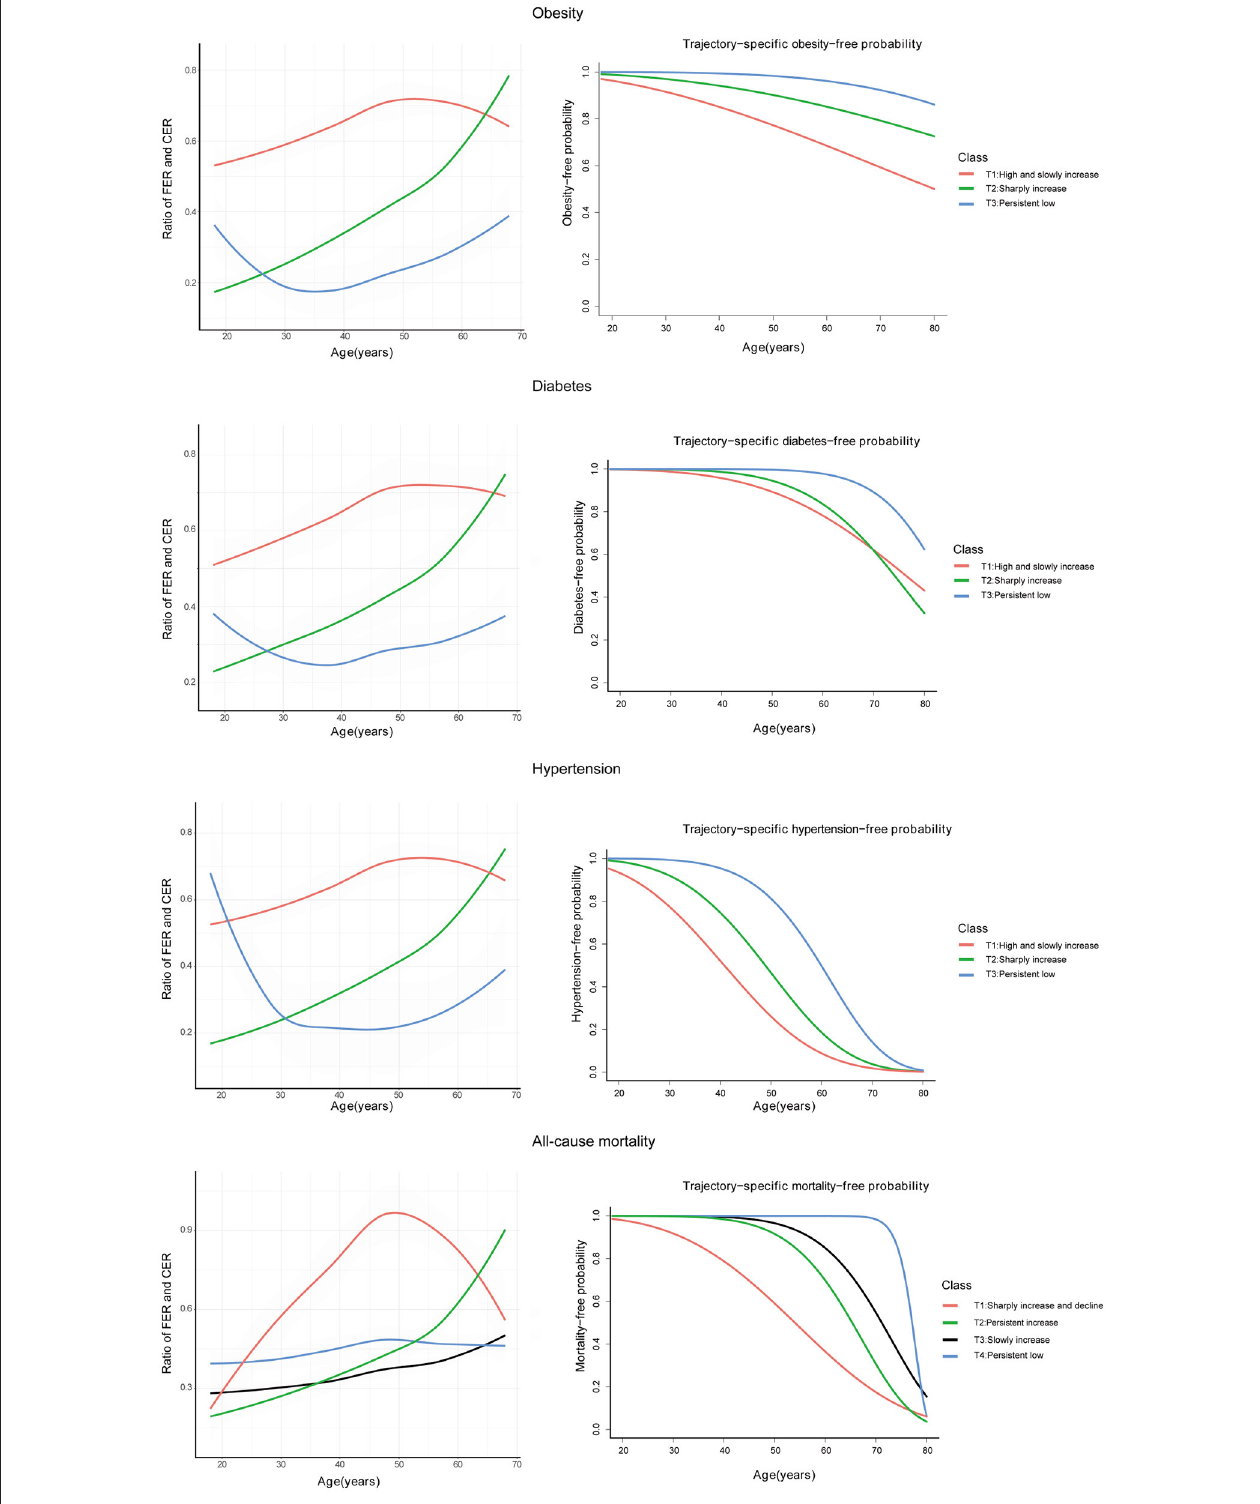
FIGURE 3 | Trajectories of the ratio between FER and CER with time-to-outcomes by joint latent trajectory model and survival rate curve of these trajectories; FER, energy provided by fat; CER, energy provided by carbohydrate.